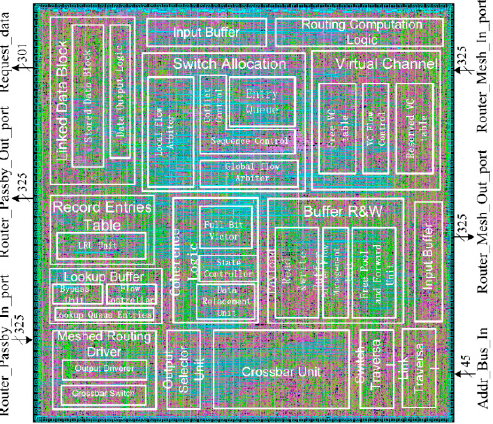
Figure 9. Layout of router architecture. Each components are marked with frames to show their on-chip compositions (not drawn in scale, this structure is built based on our previous work in [6]).